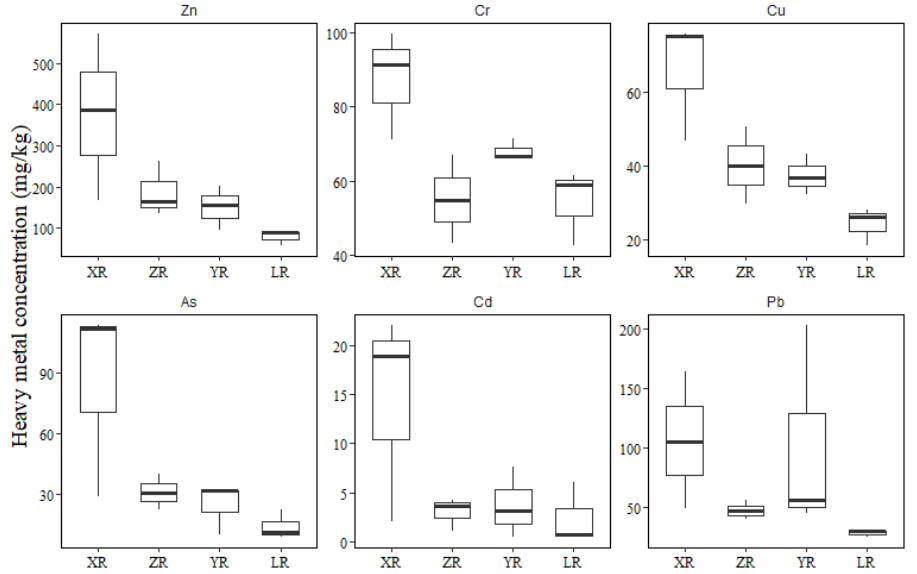
Figure 2. Heavy metal concentrations in the sediment of the four studied rivers. XR—Xiangjiang